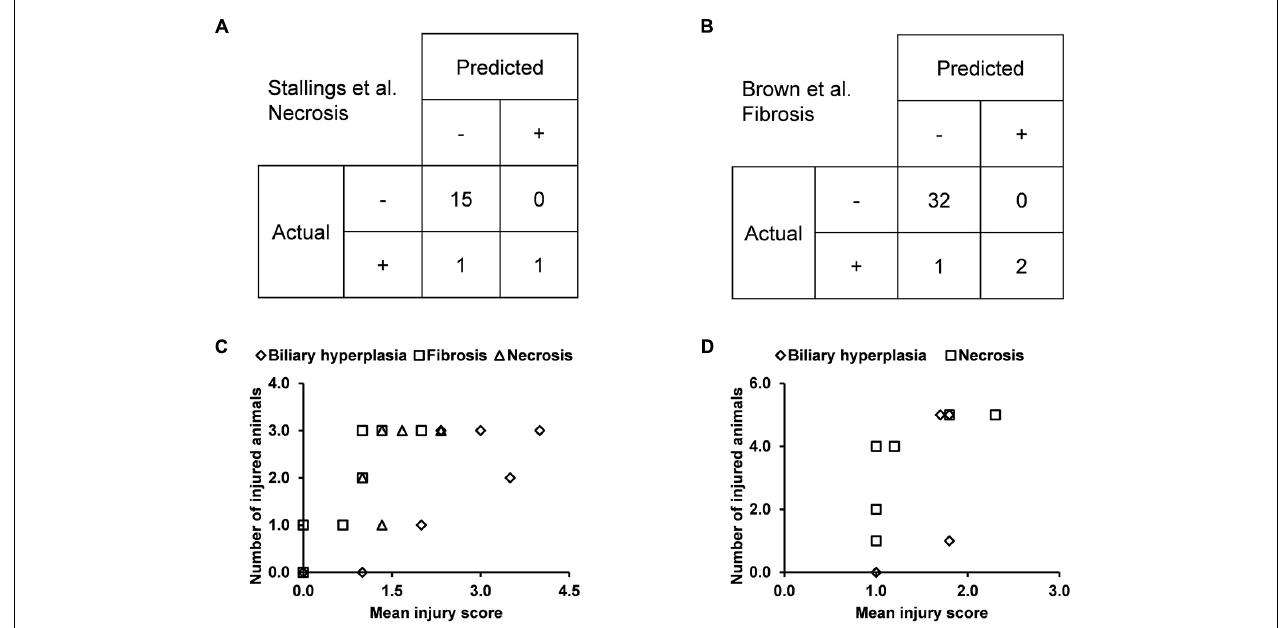
FIGURE 4 | Performance of the single-task DNN model on four external testing sets. Contingency tables of prediction for data from (A) Stallings et al. and (B) Brown et al. (C) and (D) Correlation between measures of experimentally observed injury and model-predicted injury for data from (C) Sutherland et al., and (D) Slopianka et al. Each data point represents an exposure condition (a combination of treatment duration and dose). The experimental level of injury is given by the mean injury score based on histopathology evaluation, while the predicted level of injury is given by the number of positive samples.